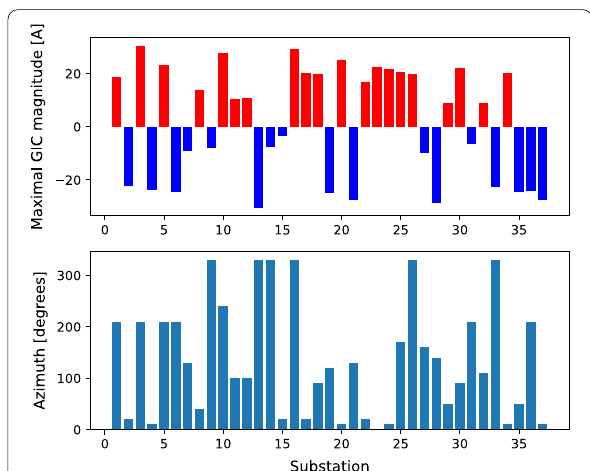
Fig. 10 In the upper panel the maximum GICs for the 1-V/km uniform field are given for each considered substation. Red bars indicate positive (from the grid to the soil), blue bar negative values. In the bottom panel, the geographical azimuths of the 1-V/ km uniform field orientations are given, in which the above given maximum GICs